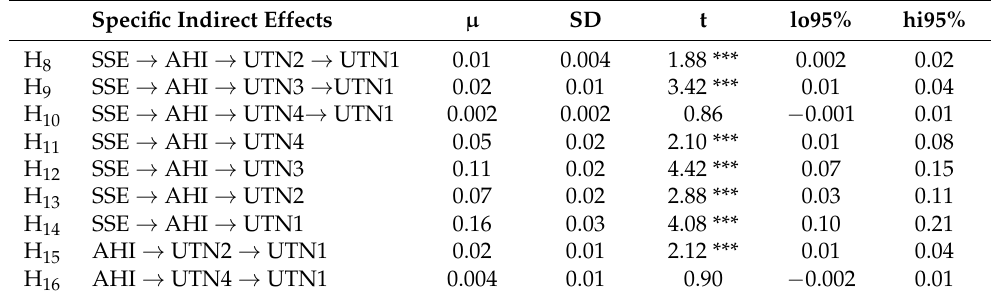
Table 6. Mediation (Regardless of